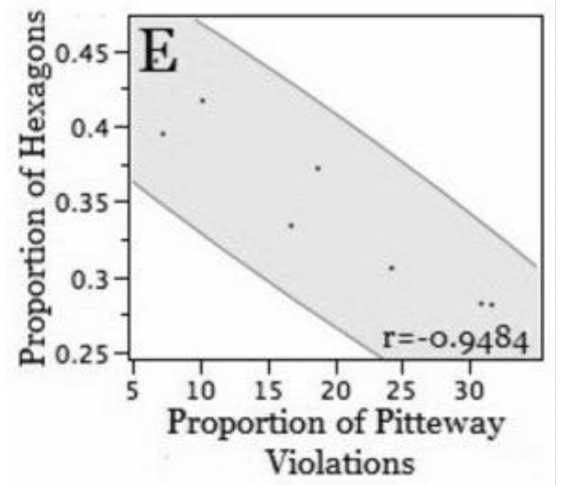
Figure 20. Parametric linear regression of the proportion of Pitteway violations with successive divisions of cells in the embryo of Drosophila melanogaster [20].